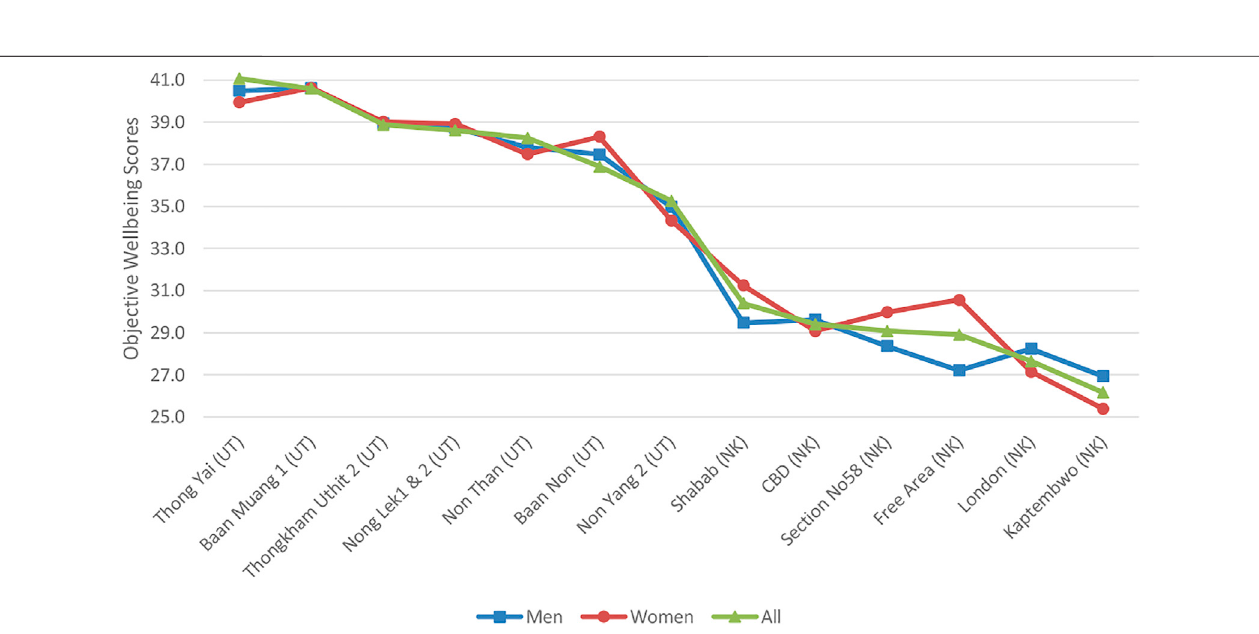
Frontiers in Sociology |